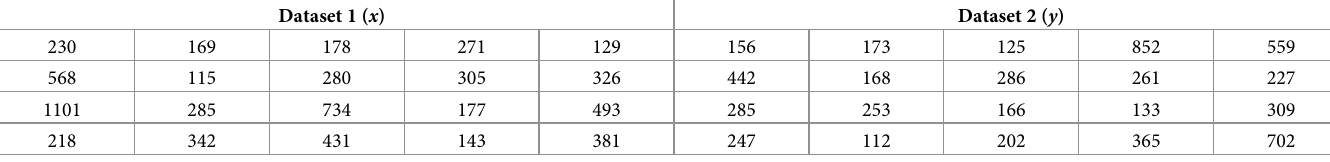
Table 1. The real datasets which were reported in Lawless (2011) [27].